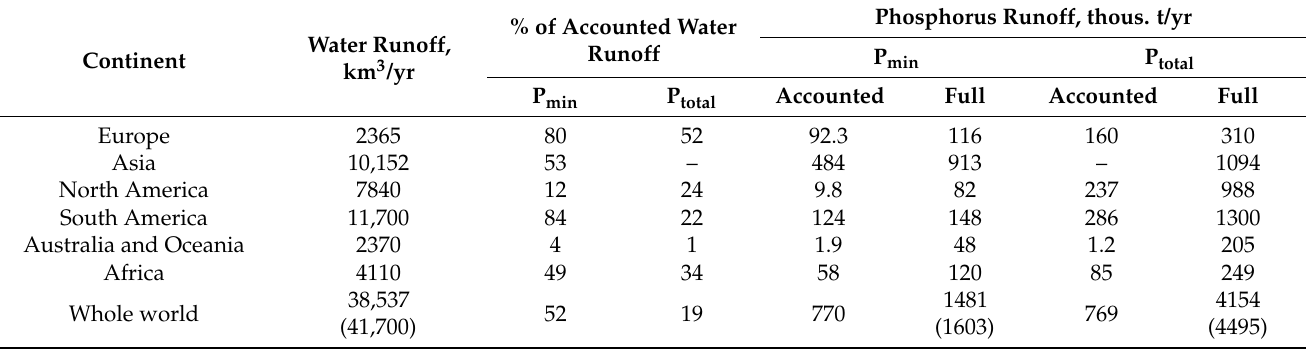
Table 14. River runoff of dissolved forms of mineral and total phosphorus [50,51] 1 .